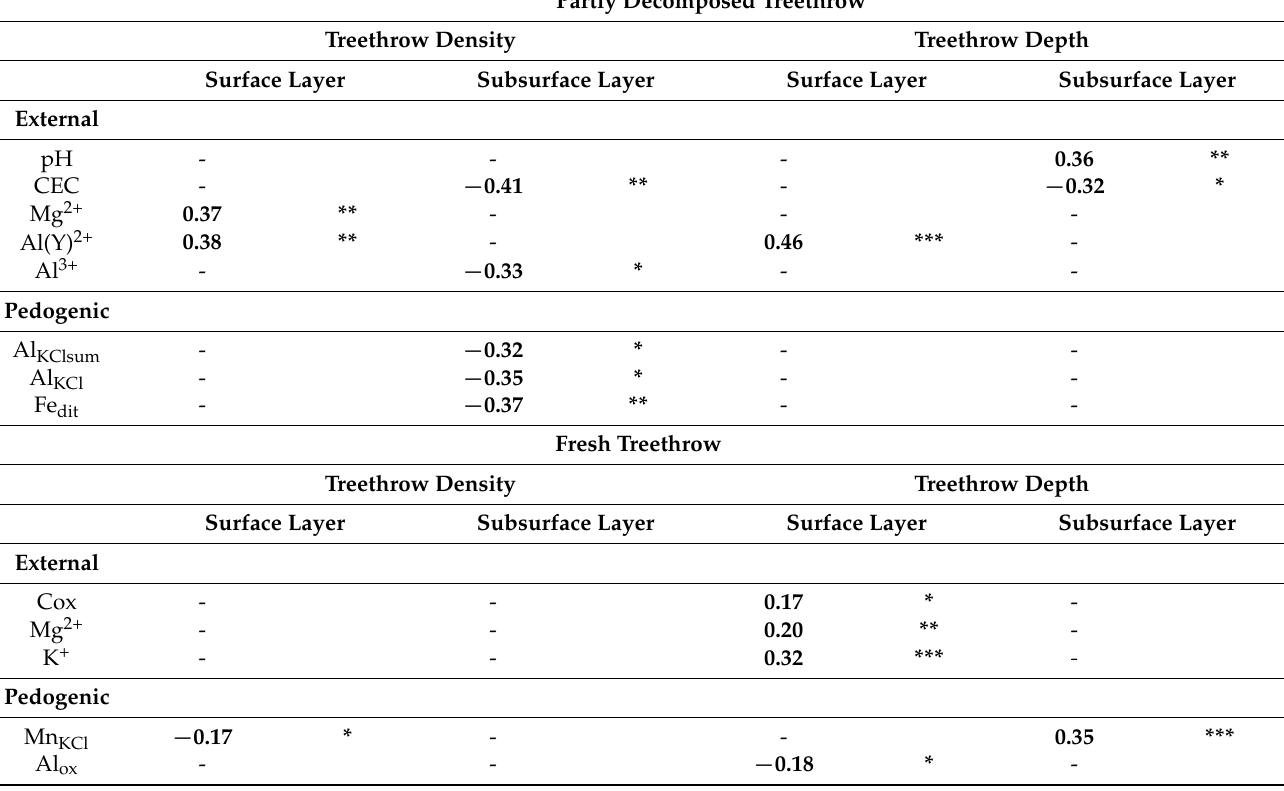
Table 5. Pearson correlation coefficient for the relationship between treethrow density and depth of treethrow and soil chemical properties for partly decomposed treethrow and fresh treethrow. Significant relationships are indicated in bold and marked according to their significance level: for treethrow density and depth of treethrow. More information can be found in Table S3 in the Supplementary